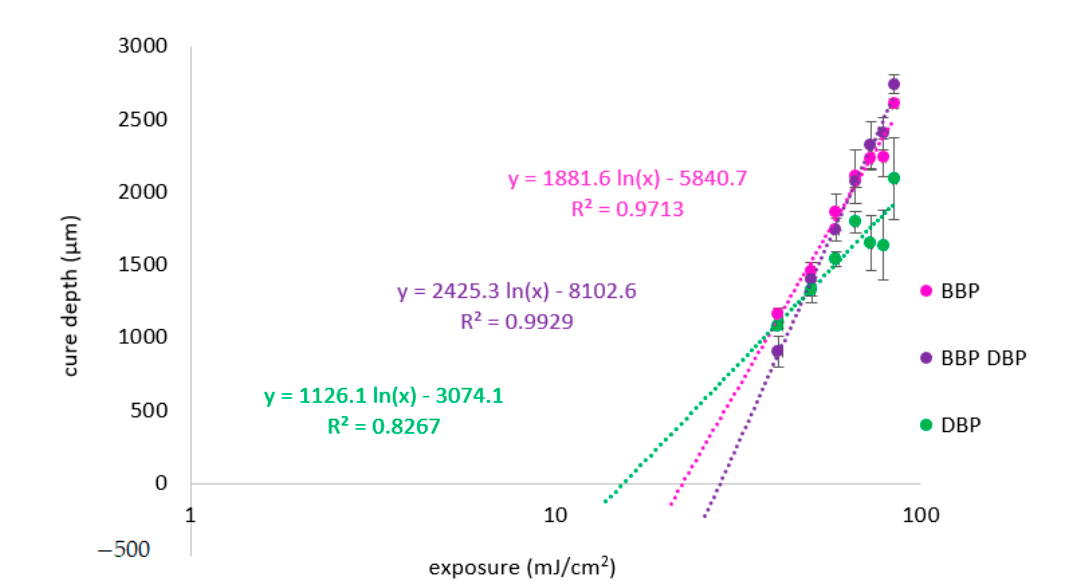
Figure 17. Jacobs working curve for lithium disilicate suspensions prepared by using various phthalates and no absorbing agent. Table 6. Penetration depth and critical polymerization energy, calculated from Figure 17 .